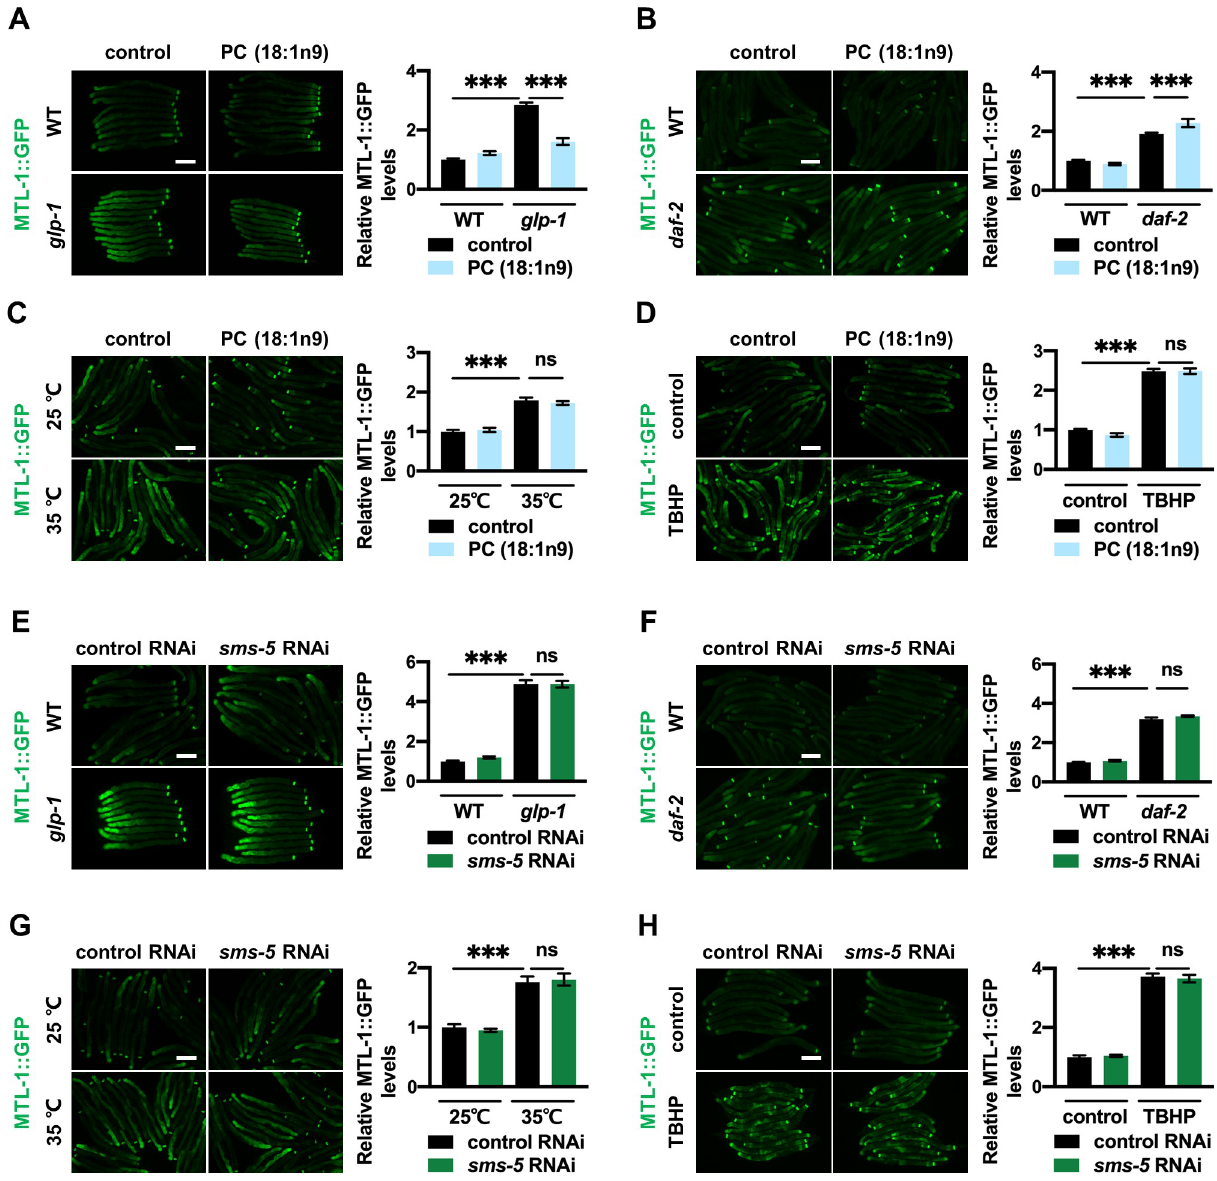
Fig 6. PC mediates DAF-16 activation in glp-1 mutants. (A-D) Effects of PC (18:1n9) supplement on MTL-1::GFP induction in glp-1 mutants (A), daf- 2 mutants (B), 35˚C heat stressed worms (C) and TBHP-treated worms (D). (E-H) Effects of sms-5 RNAi on MTL-1::GFP induction in glp-1 mutants (E), daf-2 mutants (F), 35˚C heat stressed worms (G) and TBHP-treated worms (H). Left panel, representative images. Right panel: quantification data. Scale bar = 100 μ m. Data were presented as mean ± SEM. ��� p <